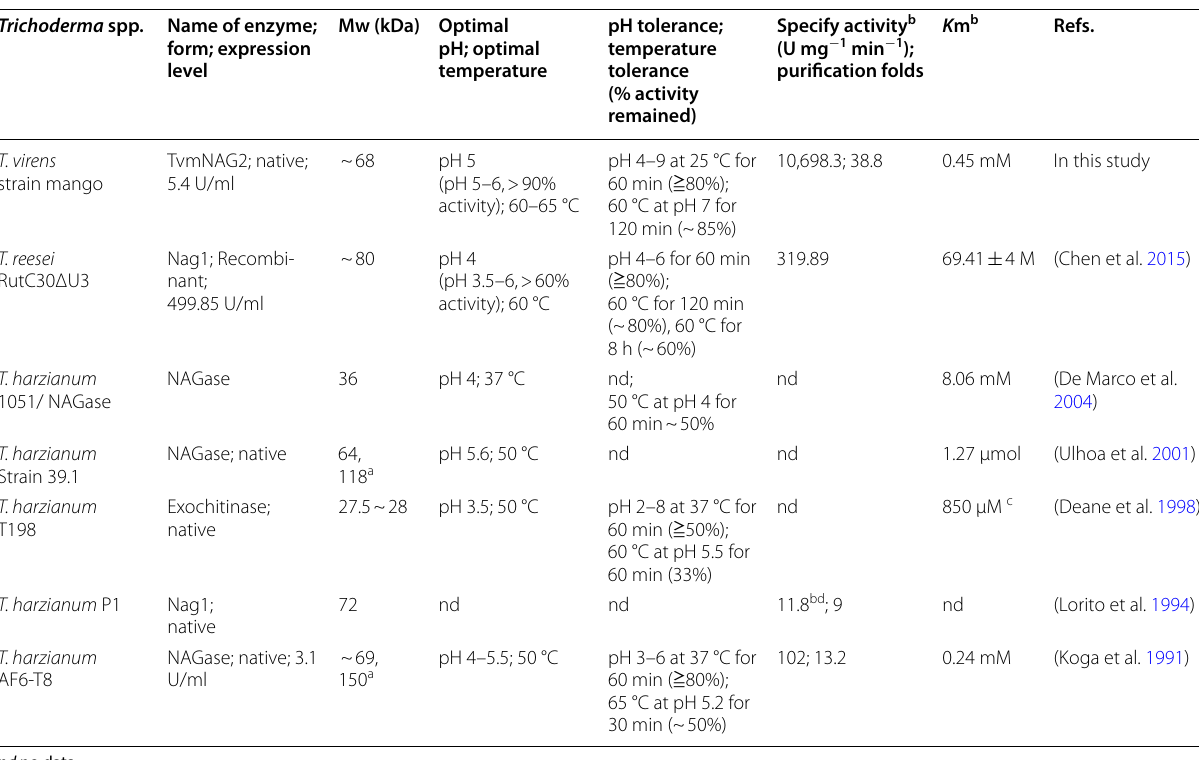
Table 2 Properties of the reported NAGase from various Trichoderma